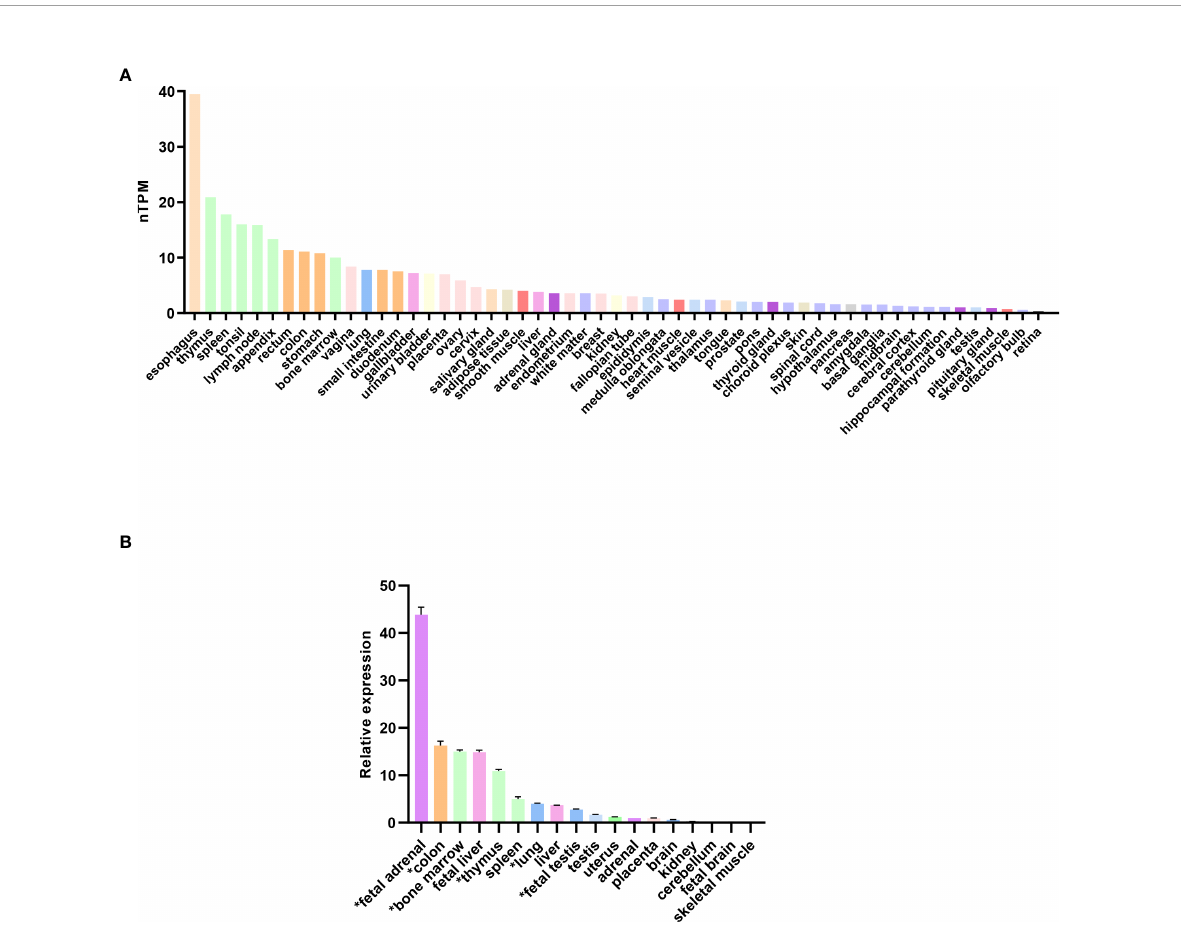
FIGURE 4 Expression of SAMD9 in human tissues. (A) RNA expression of SAMD9 in several adult human tissues. Data reproduced and modi fi ed with permission from the Human Protein Atlas (www.proteinatlas.org) (48). nTPM = normalized Transcripts Per Million. (B) SAMD9 expression in different human fetal and adult tissues showing high expression in fetal adrenal as well as in tissues affected in the clinical phenotype (adapted from Buonocore et al., 2017). Tissues especially relevant to the phenotype are highlighted (*). Data are shown as relative expression compared with GAPDH. Representative data are shown as mean ± SEM for a single study performed with triplicate technical